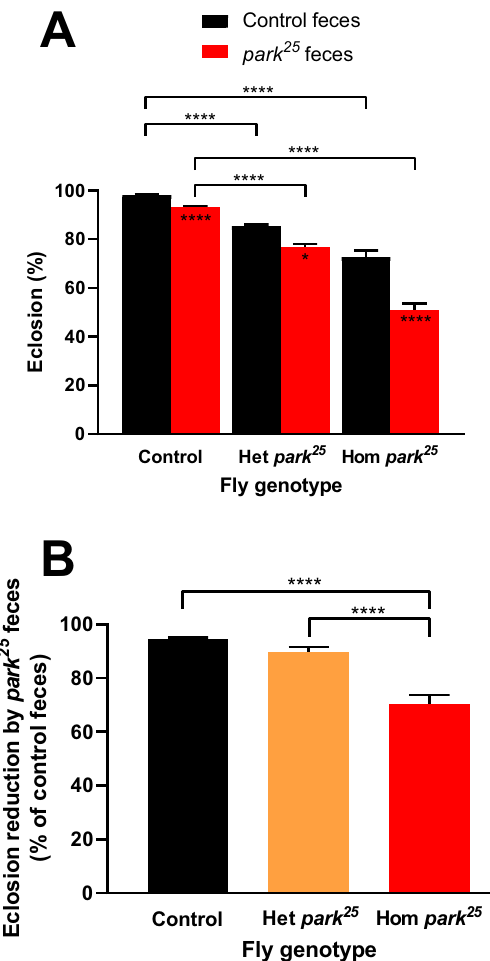
Figure 2. Eclosion rates are reduced in all fly genotypes but more in homozygous park 25 flies with park 25 feces transfer. ( A ) Total eclosion rates were determined in control, heterozygous (Het) park 25 and homozygous (Hom) park 25 flies based on the total number of pupae for each genotype. ( B ) The relative eclosion reduction caused by the park 25 fecal transfer, calculated as a percentage of the control feces eclosion, was determined. Data are presented as mean and SEM. Asterisks represent the results of a post-hoc Tukey’s multiple comparisons test. Asterisks inside the bars compare the two feces groups within each fly genotype. * = P < 0.05 and **** = P < 0.0001. Results are from 45 separate vials in each